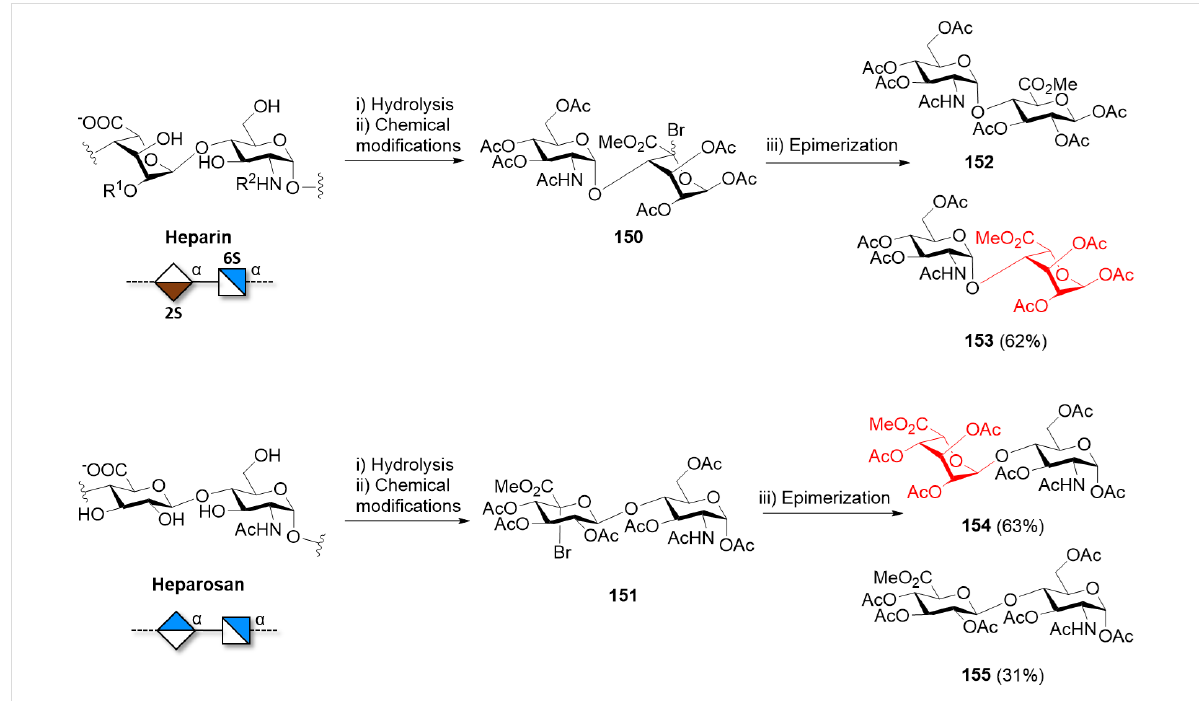
Scheme 20: Degradation of natural heparin and heparosan generated valuable disaccharides 150 and 151 that can be further converted into four disaccharide BBs 152 – 155 to assemble well-defined structures.